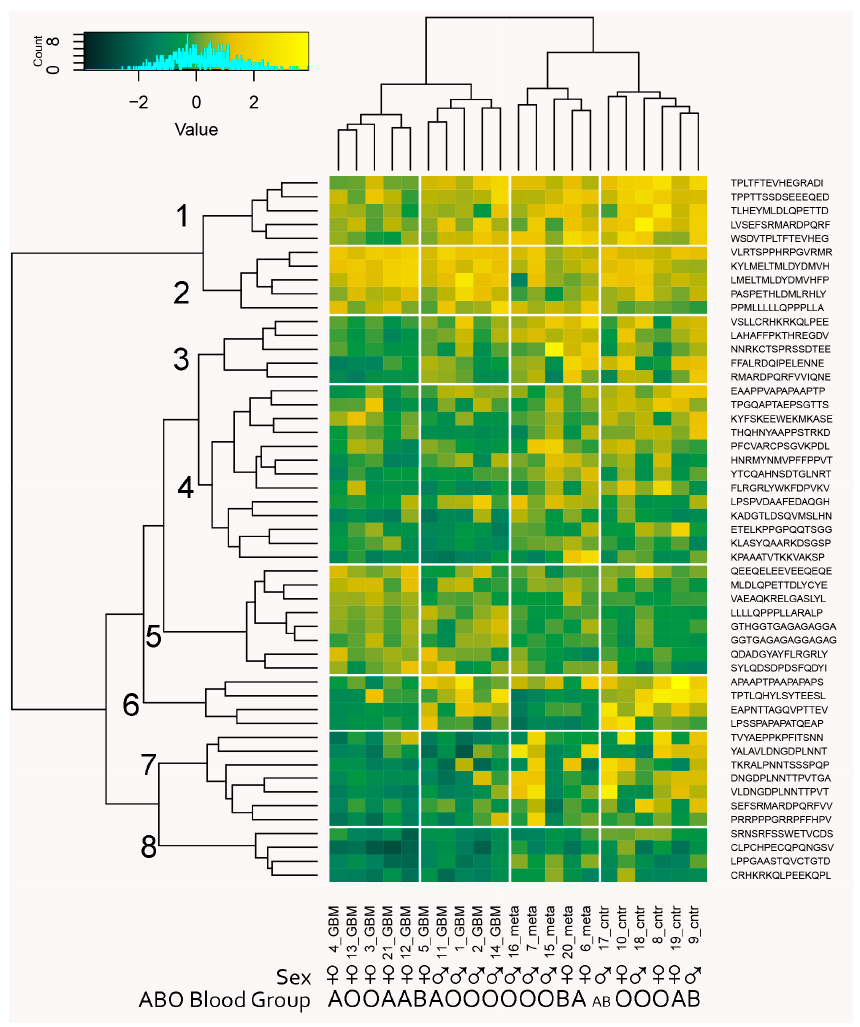
Figure 12. Biclustering heatmap plot of the patients’ IgM reactivities with the classifier profile of 51 peptides separating the three diagnostic groups. The profile provides a good clustering of both patients by diagnostic group and of peptides that fall into eight clusters. Only cluster 5 contains reactivities that were significantly increased in tumor-bearing patients, while the reactivities in clusters 1, 4, 6, 7, and 8 tended be lost in one or both of the tumor-bearing patient groups. Interestingly, clusters 1, 3, 6, and 7 distinguished two groups in the GBM group, which correlate with sex while sex was not used as a parameter in the feature